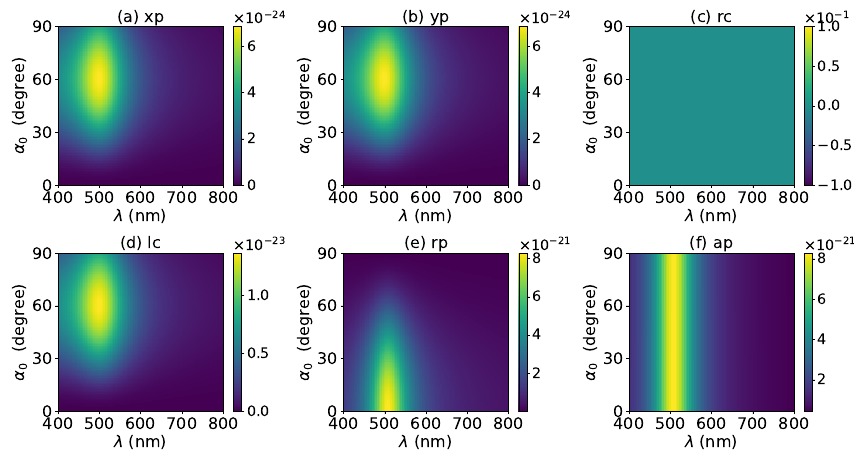
Figure 28. The same as in Figure 25, but with N = 3.